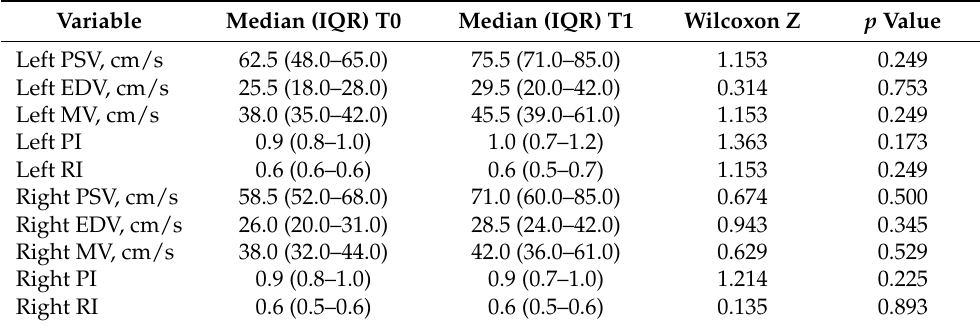
Table 4. Neurosonological features to transcranial Doppler sonography (TCD) of all participants at baseline (T0) and at follow-up (T1).